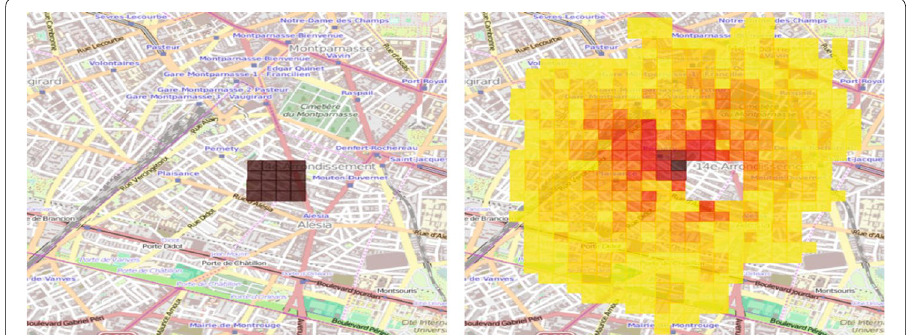
Fig. 9 Probability distribution of reported location inside and outside the fence